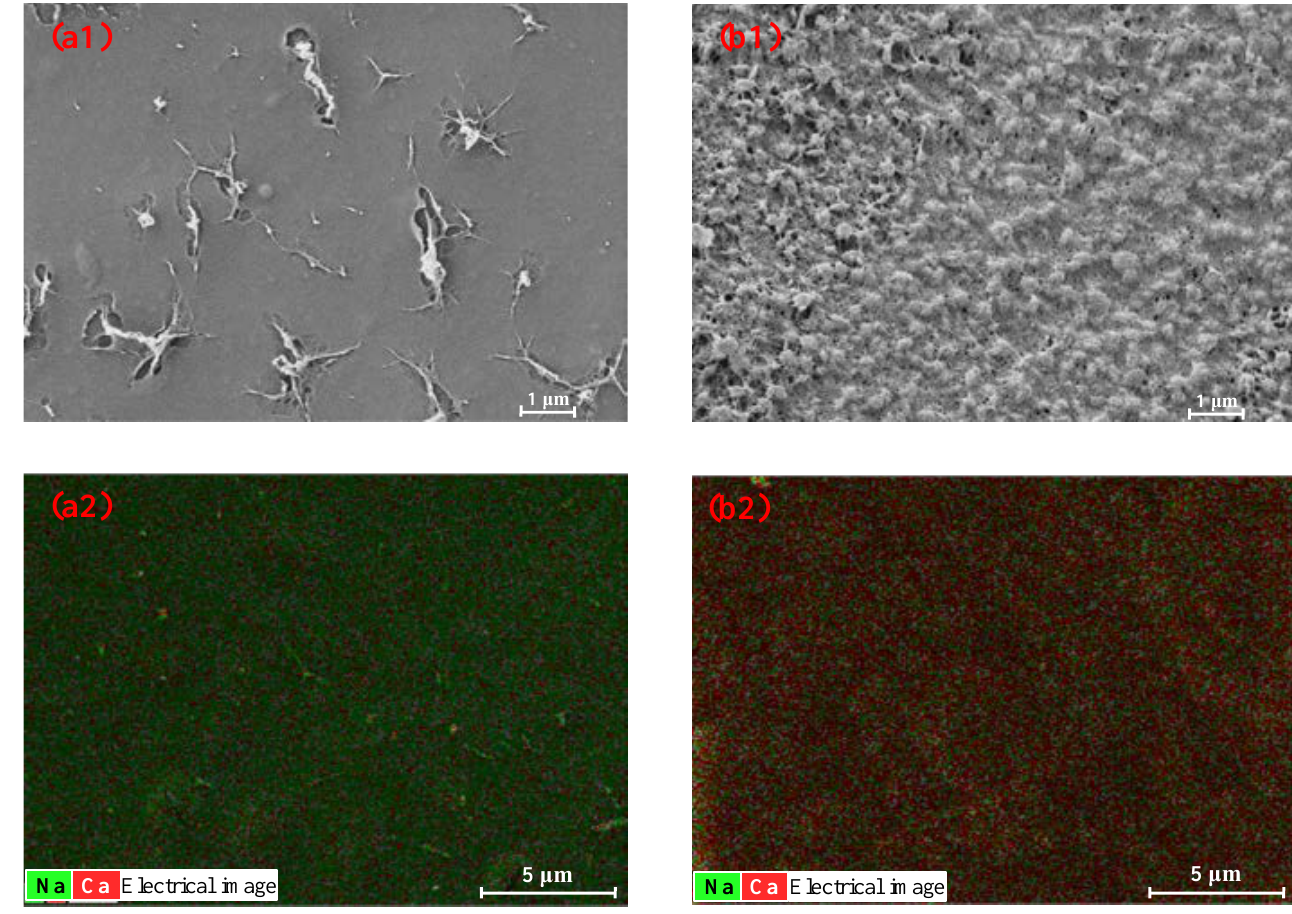
Figure 4. Scanning electron microscopy (SEM) morphology ( a1 ) and ( b1 ) and energy-dispersive spectroscopy (EDS) ( a2 ) and ( b2 ) of Ca and Na elements in the CARP surface towards the feed side. ( a1 ) and ( a2 ) represent the images for CARP formed for 1 M CaCl 2 as the draw solute, while ( b1 ) and ( b2 ) represent the images for CARP formed for 3 M CaCl 2 as the draw solute.